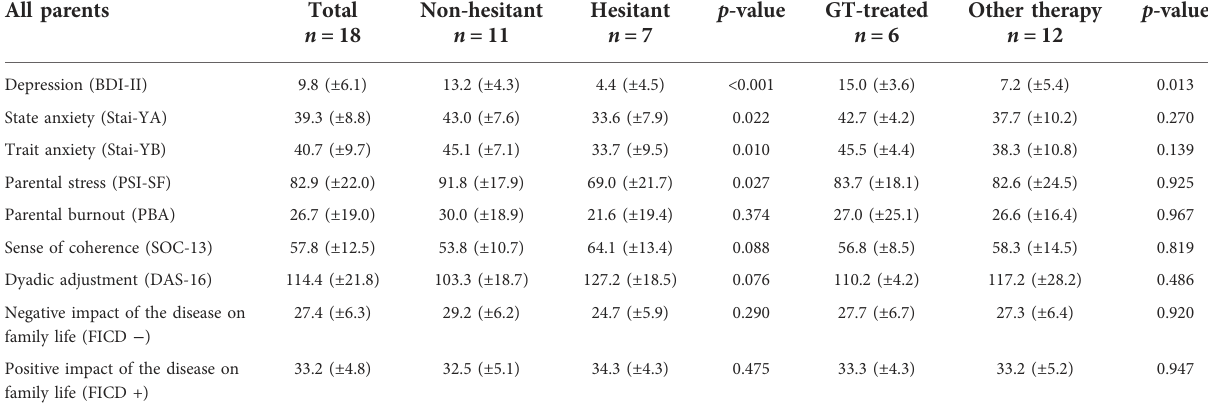
TABLE 3 Medium-term psychological effects on parents ’ lives (results are expressed as mean score±standard